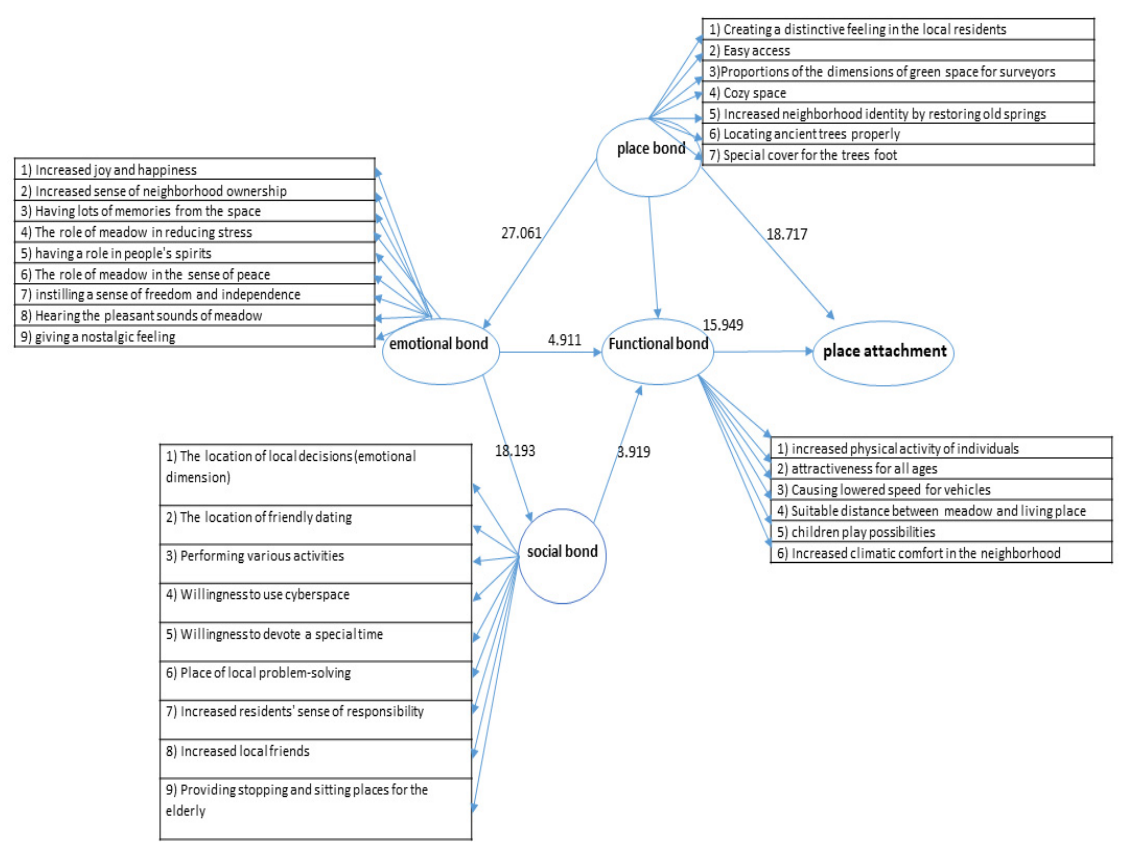
Figure 2. T-test results . Figure 2. T -test